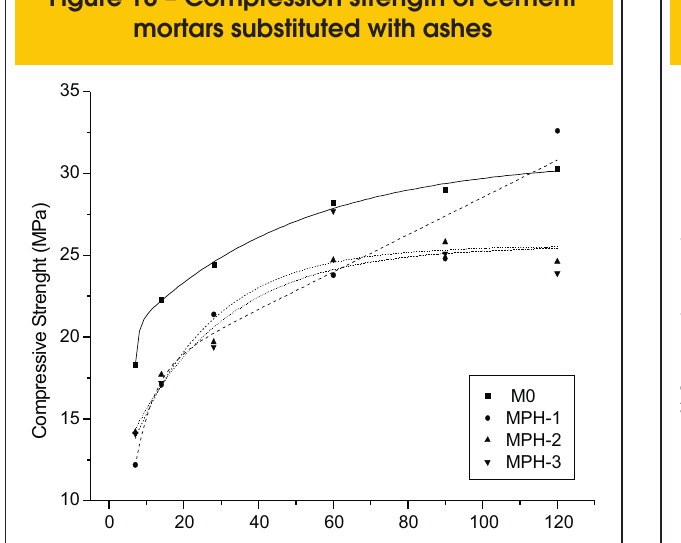
Figure 11 – Behavior of cement mortars substituted with ashes respect to